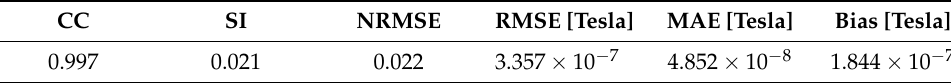
Figure 22. Magnetic field histories for the 2nd maneuver. Table 5. Validation parameters for the second